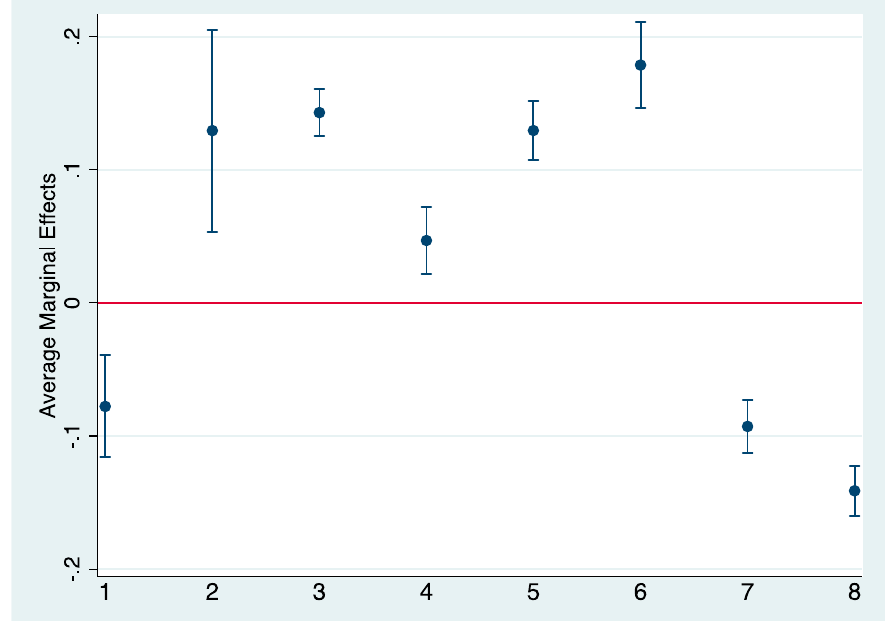
Figure 2. Bivariate Associations between Covariates and Daughters’ Early Childbearing. Note. All covariates. 1 = Coresident Mother and Father. 2 = Mother Had Psychological Problems; 3 = No Household Member with Upper Secondary School. 4 = Mother Worked; 5 = Working Class; 6 = Family Received Welfare; 7 = Families Attitudes Toward Higher Education (range = 1–7); 8 = Daughters’ School Performance (range = 0–10).